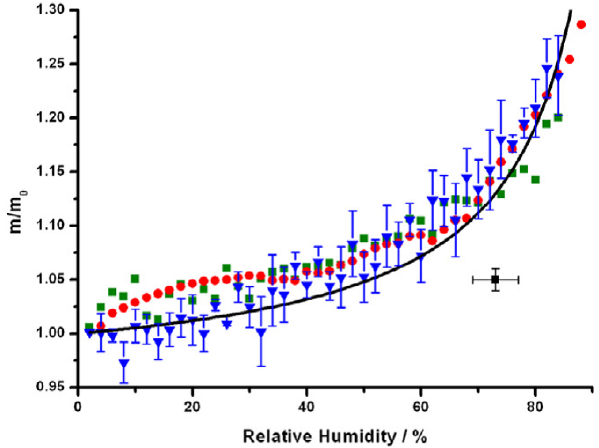
Figure 16. Mass hygroscopic growth factors (defined as the ratio of the particle mass at a given RH to the dry particle mass) of Salix caprea (red circle), Betula occidentalis (blue triangle), and Narcis- sus sp. (green square). For clarity only the error bars ( ± 1 σ ) are shown for Betula occidentalis, and the mass hygroscopic growth factors have similar uncertainties for the other two pollen species. The black square represents water uptake reported by Diehl et al. (2001), and the black curve represents the fitted mass hygro- scopic growth curve using the κ -Kohler theory. Reprint with per- mission by Pope (2010). Copyright 2010 IOP Publishing